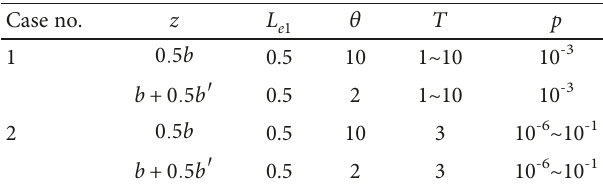
The parameters in Case 1 are used to discuss the e ff ect of the thicknessratio τ ( τ = b / b ′ ). The parameters in Case 2 are used to discuss the e ff ect of hydraulic conductivity ratio p ( p = K ′ / K